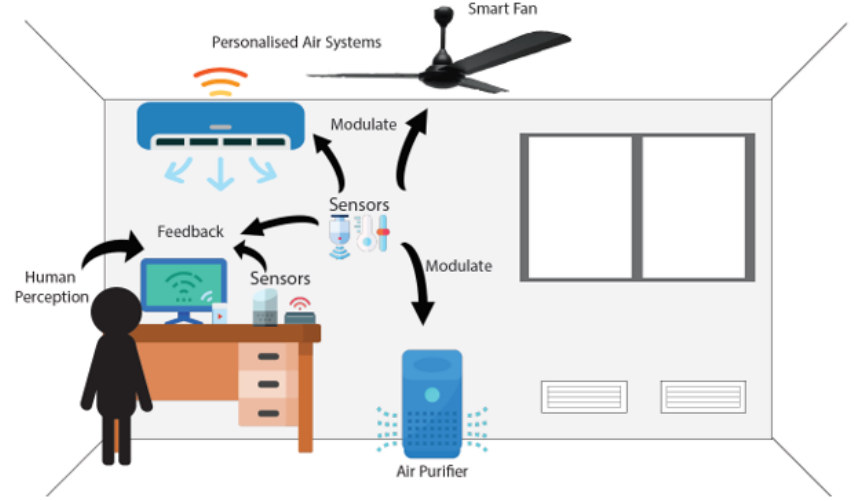
Figure 6. Personalized Indoor Air Quality Sensing (PIAQ) System.